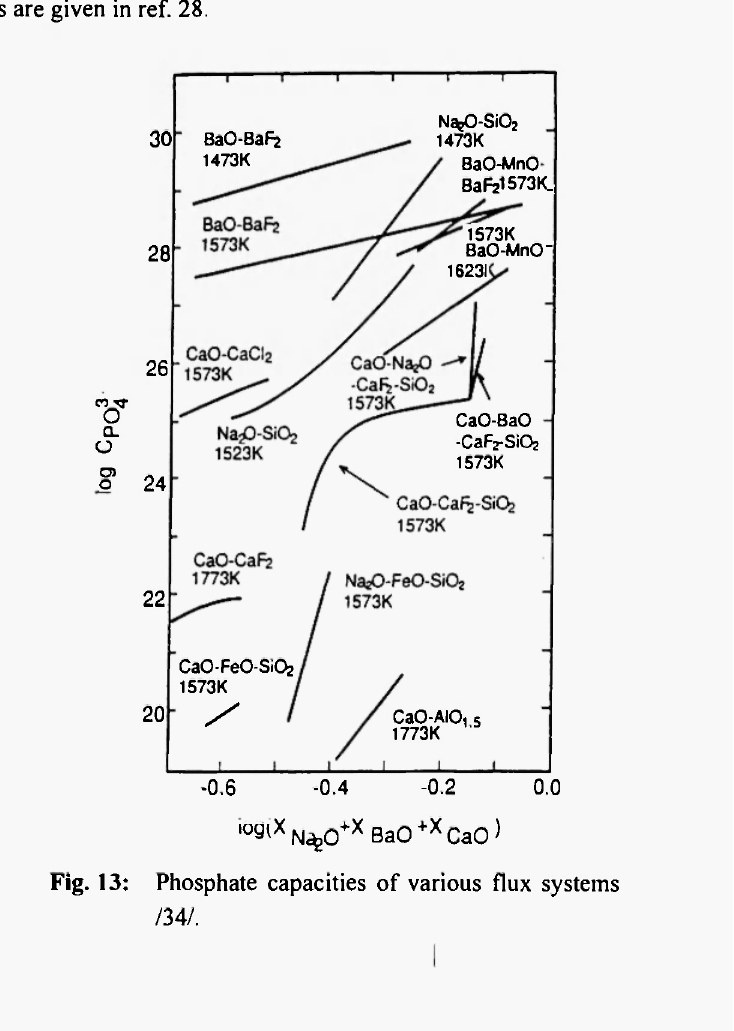
Phosphate capacities of various flux systems